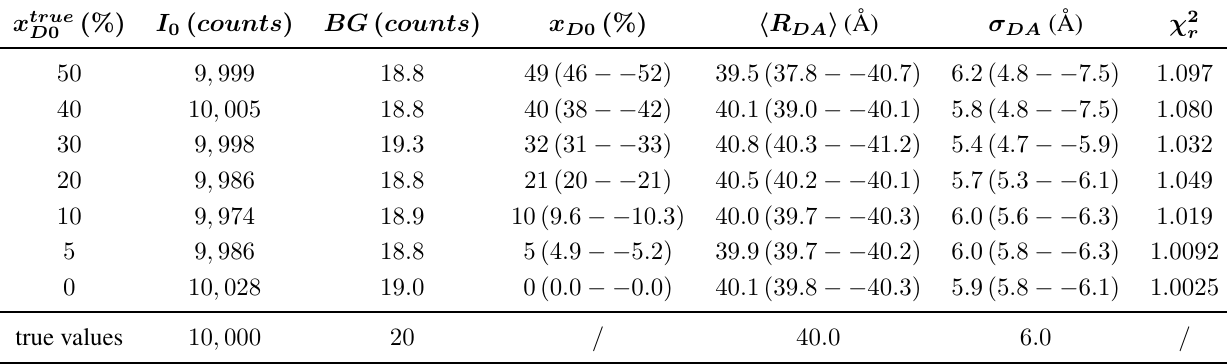
Table A1. Fitting parameters, as obtained from the fits of the artificial time decays, as well as the true values (first column and last line) used to build the model functions. The confidence intervals at one standard deviation ( 68 . 3 %) where calculated with support plane analysis. In more detail, I is the amplitude at time zero, BG is the constant background, 0 x (cid:105) is the mean inter-dye distance and σ is the donor-only fraction, (cid:104) R D 0 DA the inter-dye distance distribution. Here, a high FRET sample with a true value of the mean (cid:105) = 40 Å is used. For more information, see Sections 3.6 and 3.7. inter-dye distance of (cid:104) R DA x true D 0